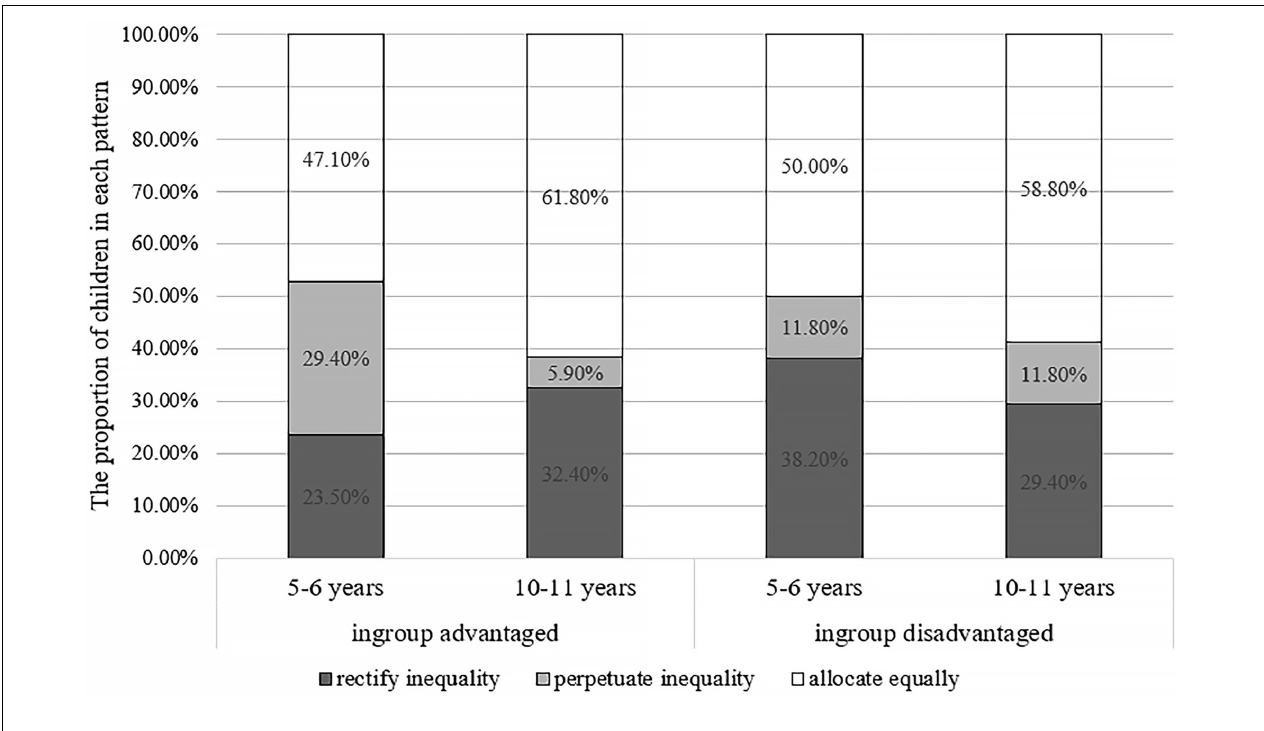
FIGURE 2 | Percentage of allocation patterns between groups in experiment 1. TABLE 1 | Children’s justifications for allocation in the context of inequality without an explicit